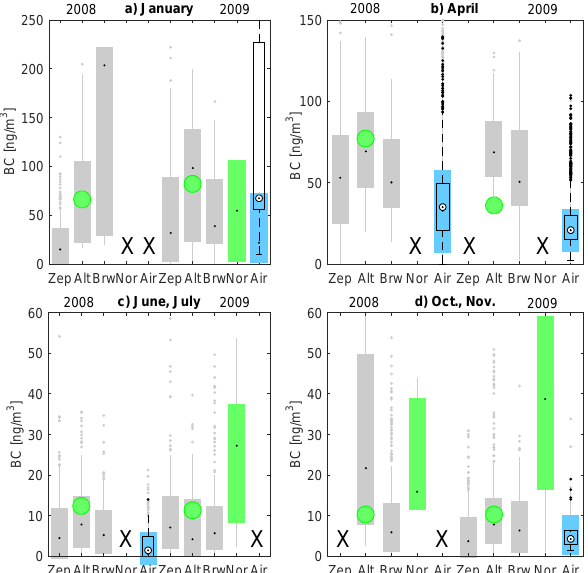
Figure 11. Comparison of eBC (ngm − 3 ) measured at the stations Zeppelin (Zep), Alert (Alt), and Barrow (Brw) (grey bars), EC measured at Alert and Station Nord (Nord) (green dots and bars) and rBC (ngm − 3 ) measured by aircraft (Air) in the lowest 3km and 1km, north of 70 ◦ N (blue bars) for the years 2008 and 2009 for (a) January, (b) April, (c) June and July and (d) October and November. The black dots represent the median, and the boxes the interquartile range. For the aircraft measurements, the blue boxes show the results for the lowest 3km; the black box outlines show the results for the lowest